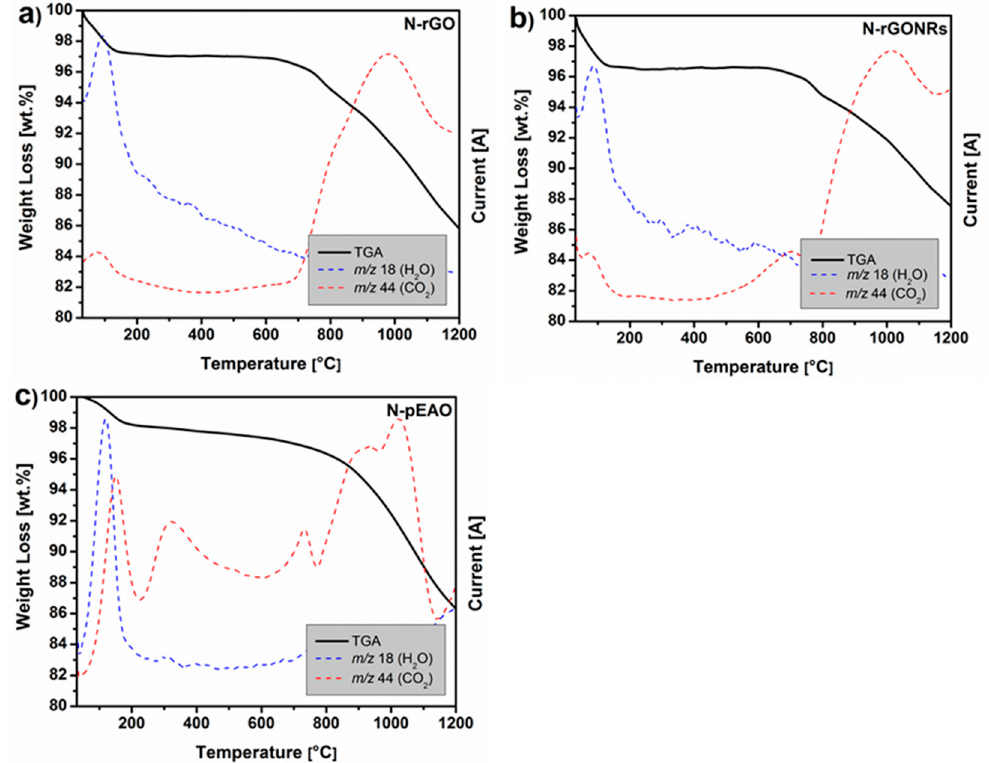
Figure 3. Evolved gas analysis done by TGA (black curve) coupled to MS fragments m/z 18 (H 2 O + ) (blue curve) and m/z 44 (CO 2+ ) (red curve) for ( a ) N ‐ rGO, ( b ) N ‐ rGONRs, and ( c ) N ‐ pEAO.